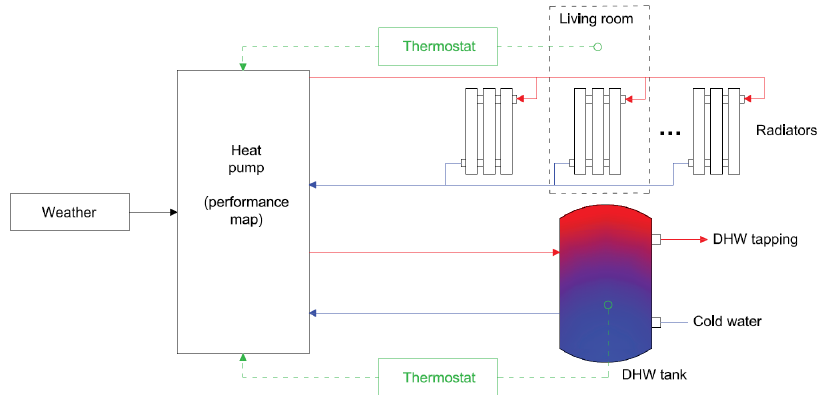
Figure 2. Schematic view of the heating system.